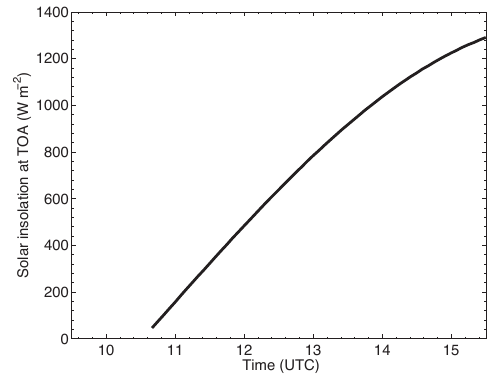
Fig. 5. Solar insolation at TOA as it varies over simulation time for the base case LES. All experimental simulations have the same solar insolation as the base